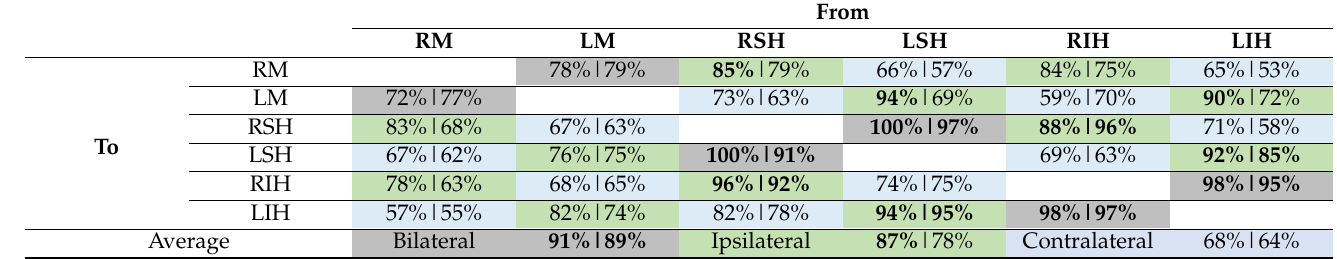
Table 1. Average percentages of healthy/dysphagic subjects that exceeded the pre-established threshold for each interaction muscle pair. Bilateral, ipsilateral, and contralateral muscles are shaded in grey, green, and blue respectively. The overall average percentages of bilateral, ipsilateral, and contralateral muscle interactions are shown at the bottom of the table. Percentages above 85% are shown in bold. From RM LM RSH LSH LIH